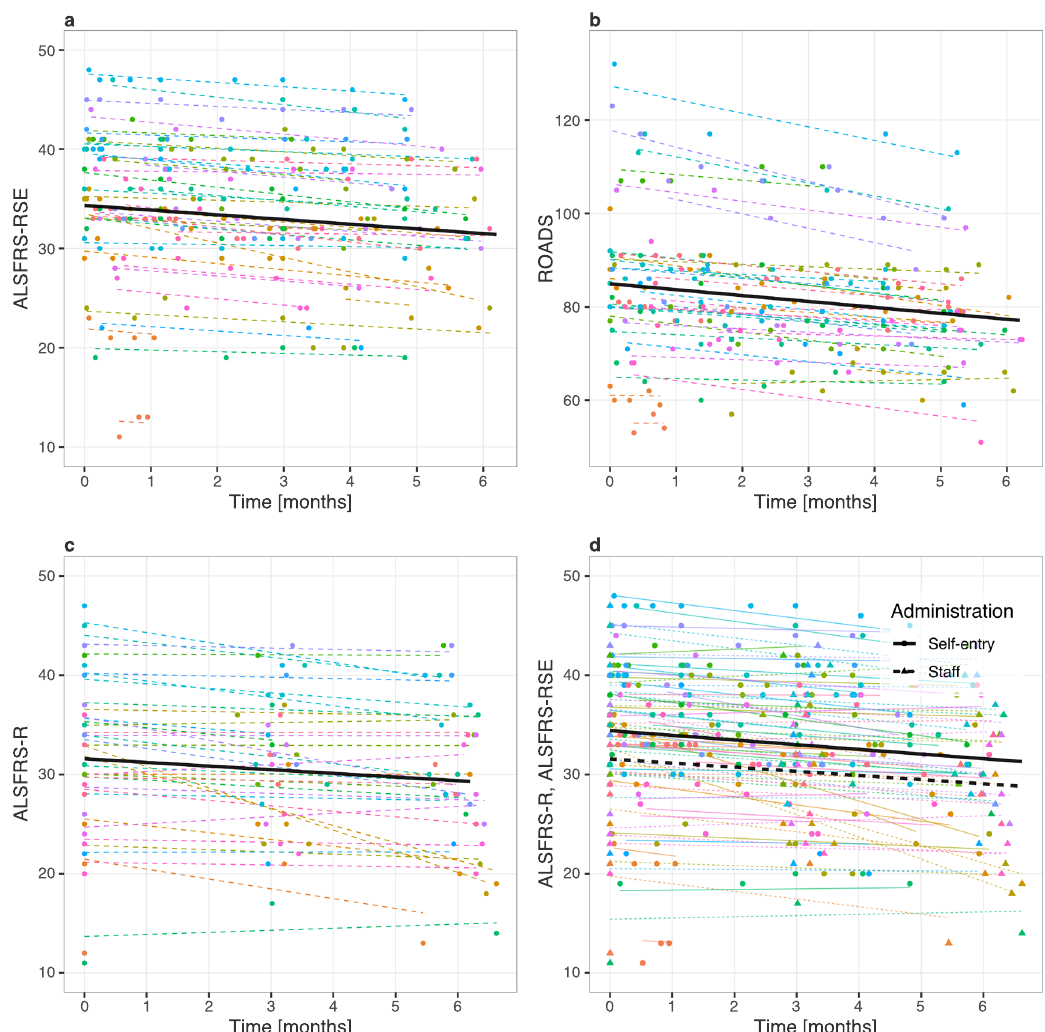
Fig. 2 Estimated survey baseline and change over time. a Self-entry Amyotrophic Lateral Sclerosis Functional Rating Scale-Revised (ALSFRS- RSE). b Rasch-built Overall ALS Disability Scale (ROADS). c Staff-administered Amyotrophic Lateral Sclerosis Functional Rating Scale-Revised (ALSFRS-R). d Combined ALSFRS-RSE and ALSFRS-R plots. Participants are color coded and the color scheme is maintained across plots: lines represent participant-speci fi c conditional means, points represent observed values. The thick black lines in a , b , and c represent the population means. In d , the population baselines and slopes are estimated for both the ALSFRS-R (staff-administered) and ALSFRS-RSE (self- entry) values in a single regression